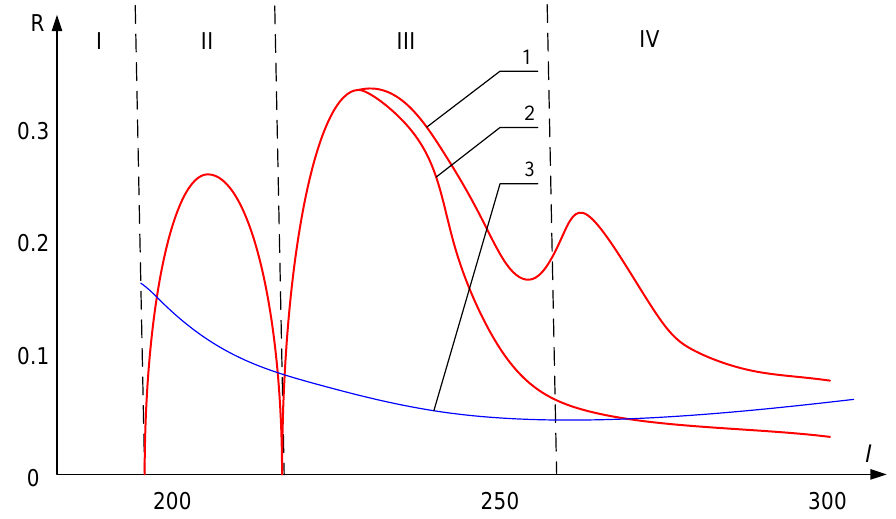
Figure 4. Generator self-excitation zones (the installed power of the transmitting station is equal to the natural power of the line).